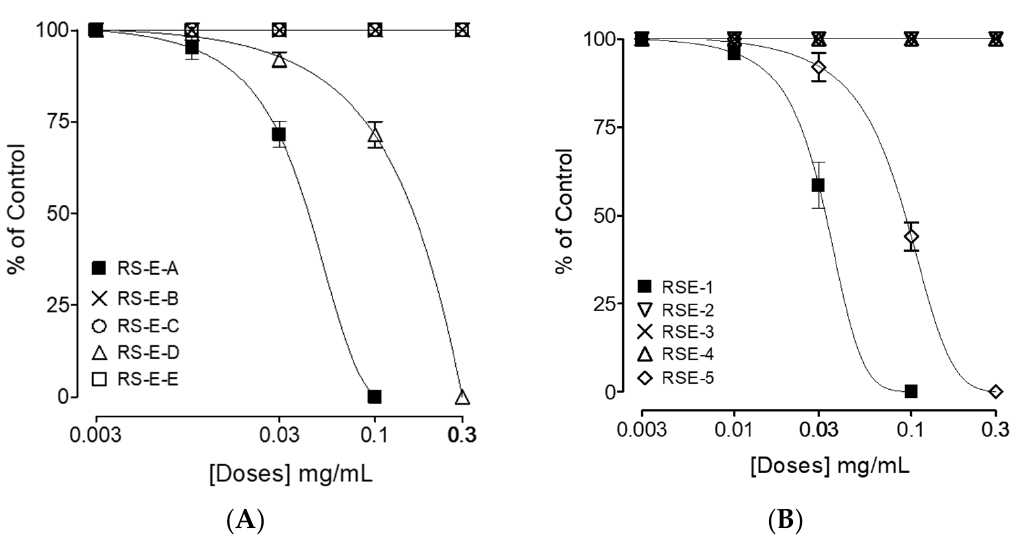
Figure 2. Concentration-dependent inhibitory (bronchodilatory) effects of ( A ) R. stricta ethyl acetate (RS-E) Sephadex LH 20 column fractions, ( B ) Compounds 1–5 against carbachol (CCh; 1 µ M) induced contraction in isolated guinea pig tracheal preparations. Symbols represent mean ± SEM; n = 4.